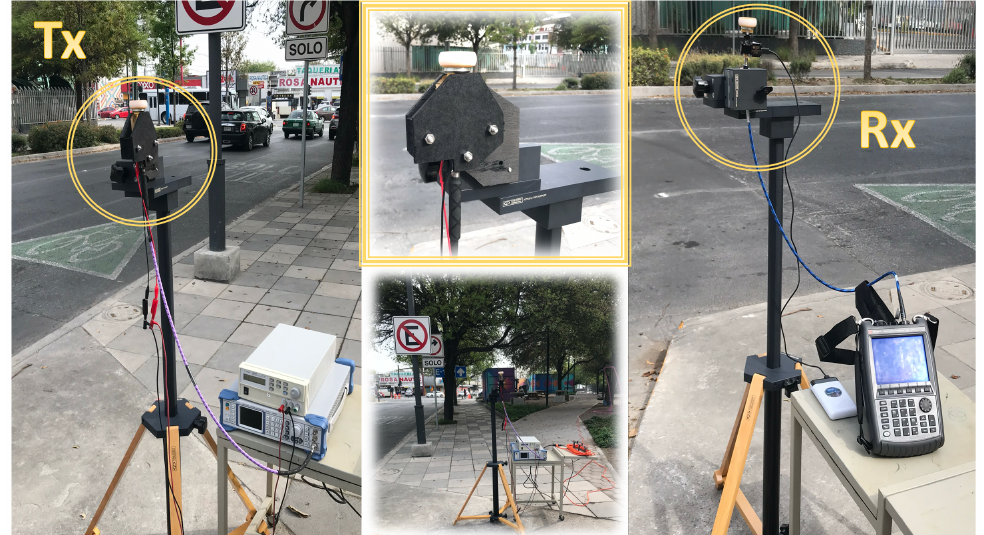
Figure 7. Collage of the measurement equipment used during the measurement campaign and detailed view of the transmitter system as well as the receiver composition.